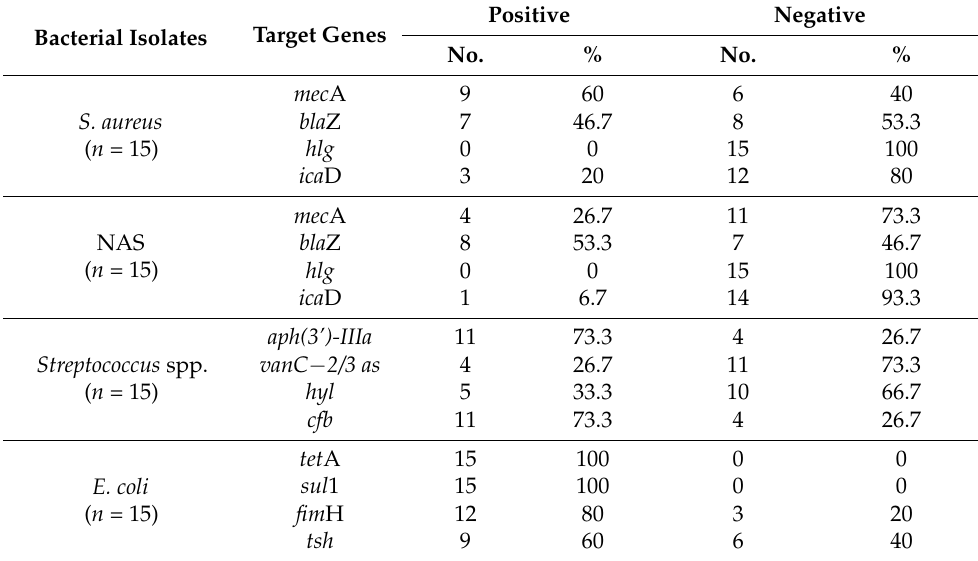
Table 7. Prevalence of resistance and virulence-associated genes among the tested MDR isolates. Bacterial Isolates Target